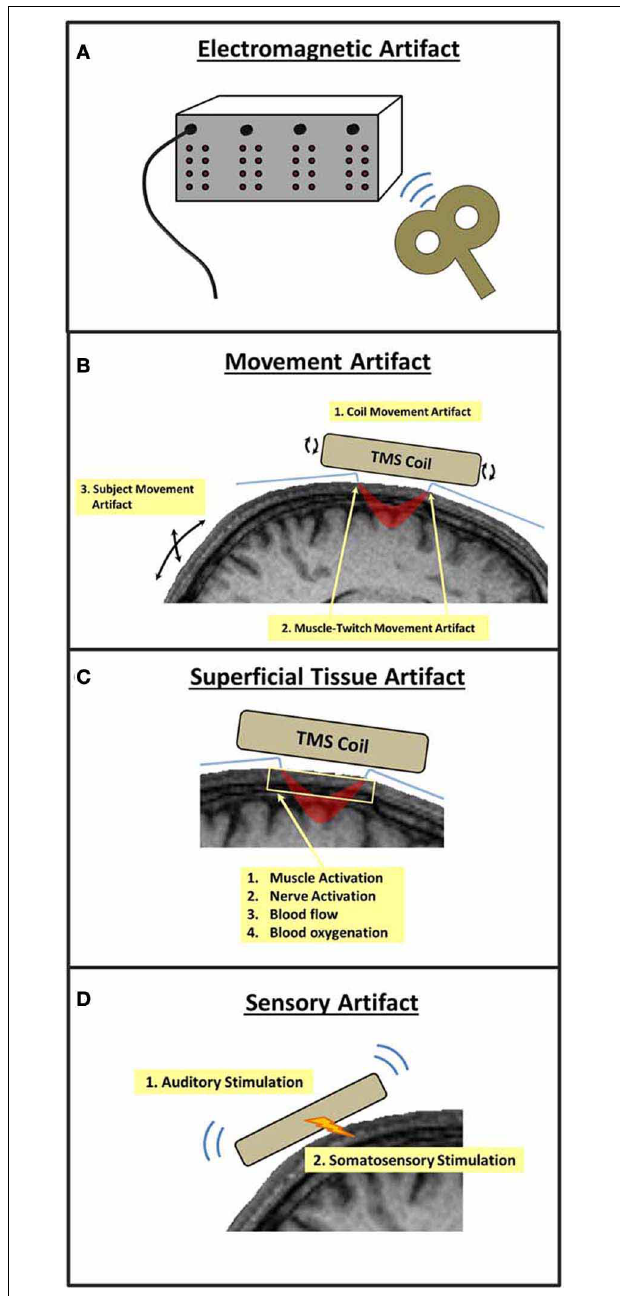
FIGURE 3 | Potential sources of TMS-related artifacts in TMS-fNIRS and TMS-EROS experiments. A TMS pulse may (A) introduce interference or noise within the optical imaging instrumentation, (B) cause movement of the subject and/or optical fibers, (C) induce changes in the absorption and scattering properties of superficial tissue of the scalp and skull, or (D) induce neural activations through auditory or somatosensory stimulation.